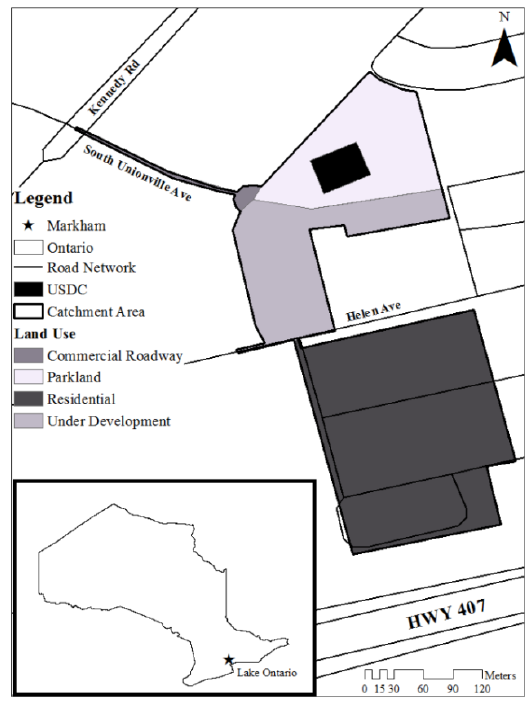
Figure 1. South Unionville Underground Stormwater Detention Chambers (USDC) Location and Service Area.